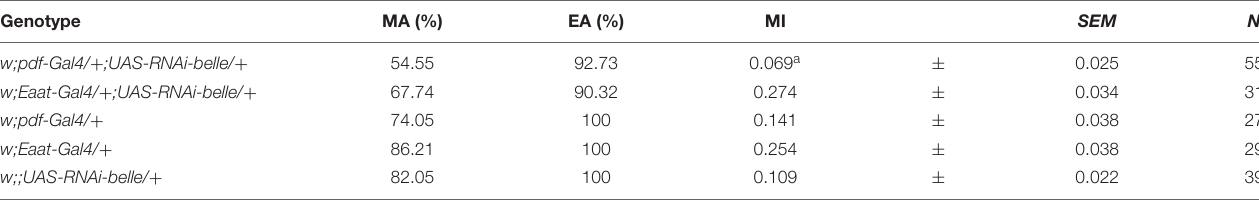
TABLE 2 | Locomotor activity of belle Knock-Down flies in entrainment conditions (LD).